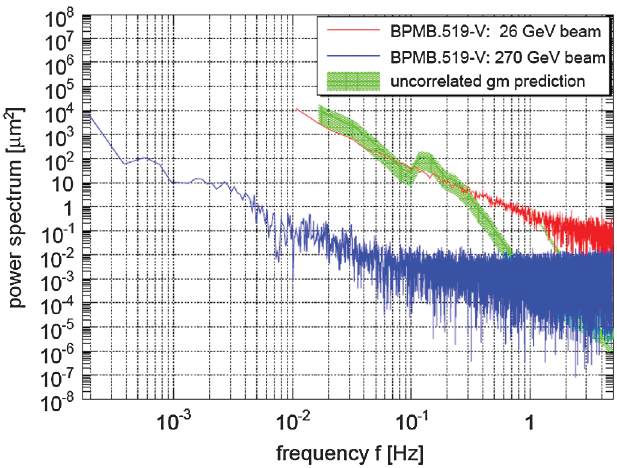
FIG. 12. (Color) Power spectra of orbit movement at 26 and 270 GeV in the SPS (from Ref. [23]).